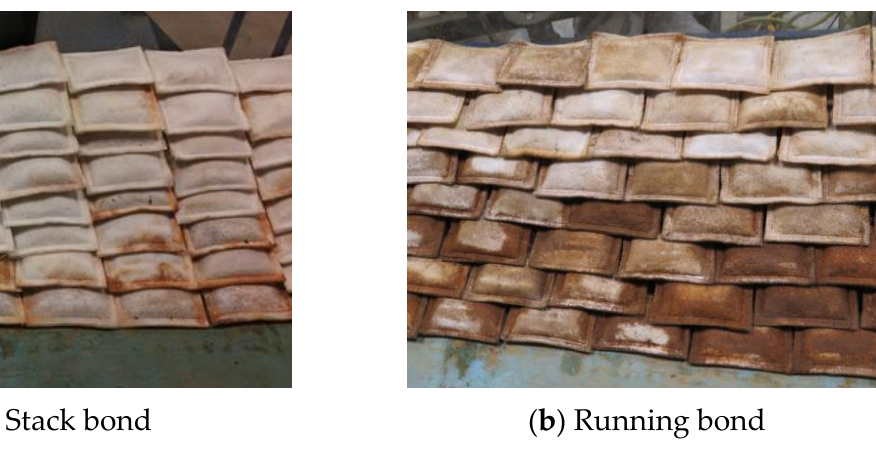
Figure 3. Revetment construction.